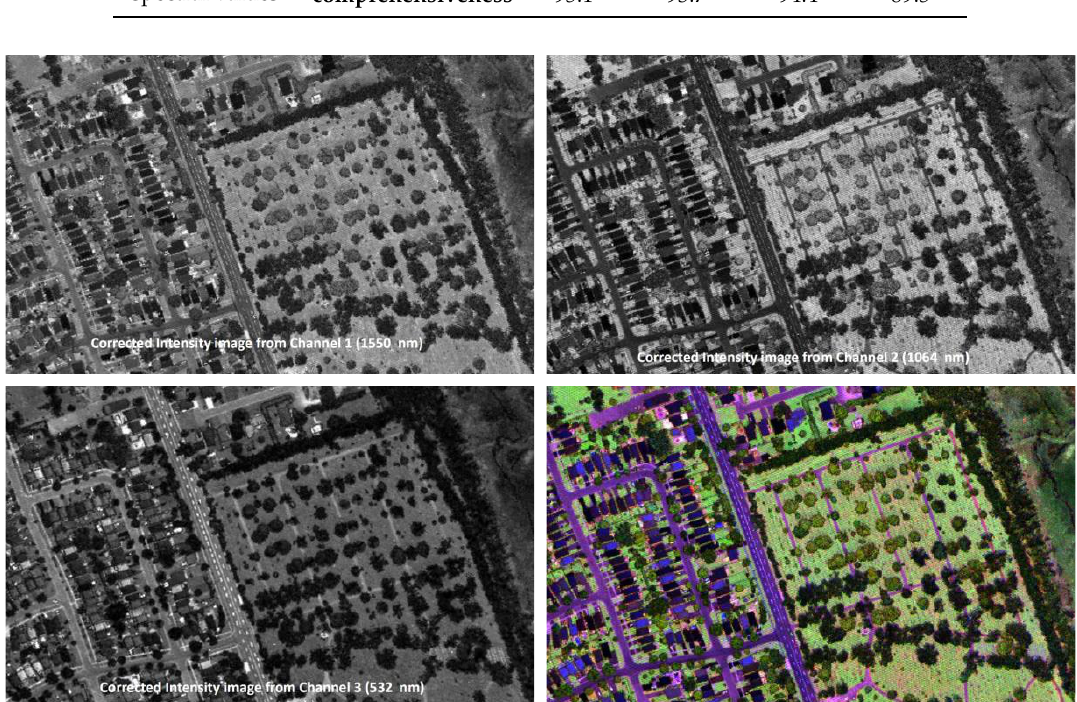
Figure 8. The corrected intensity images from different channel and the fused false colored image.